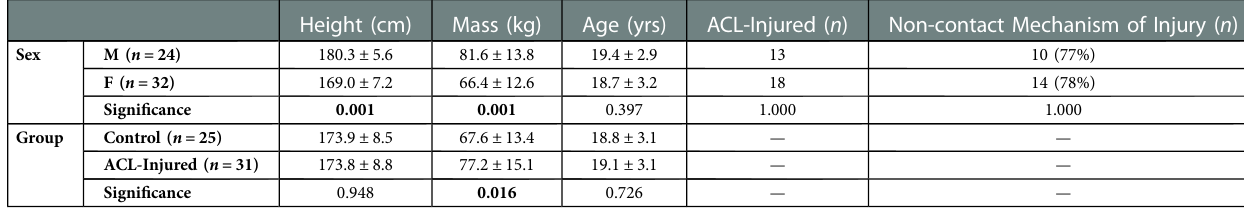
TABLE 1 Population demographics (divided by sex and by